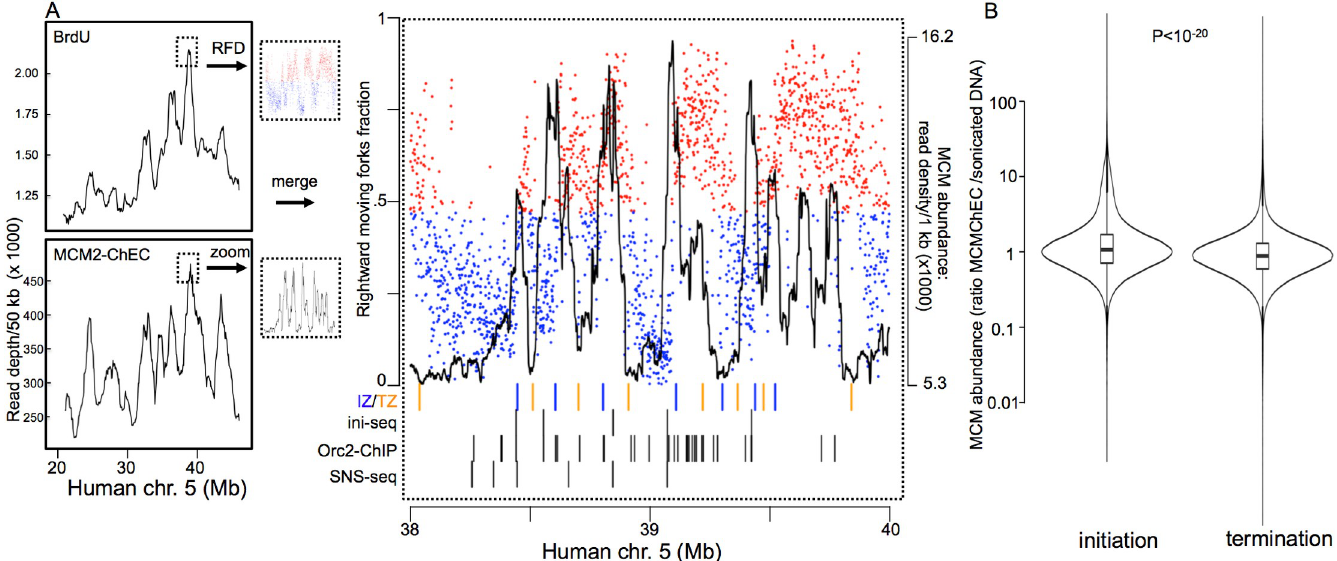
Fig 7. MCM binding in humans with respect to replication initiation and termination zones. (A) Replication, as determined by BrdU incorporation [57] upper left panel) and MCM binding expressed as Mcm2-ChEC read depth of all fragment sizes is shown for HeLa cells. Right panel shows blow-up of indicated area with (red and blue dots are used to emphasize direction of majority of synthesis; data from Petryk et al., 2016 [49]) and MCM binding (black). The centers of initiation and terminations zones (IZ and TZ) are marked by red and yellow tick marks, respectively. Black tick marks show locations of Orc-ChIP [50], initiation site sequencing (ini- seq) [51], and small nascent DNA strand sequencing (SNS-seq) peaks [52]. Data from both MCM2-ChEC replicas were included in this analysis; the two replicas are analyzed separately in S15 Fig. (B) Analysis of replication initiation and termination zones on chr18 show higher MCM binding at the former than the latter (P < 10 − 20 ). MCM binding was expressed as MCM2-ChEC/sonicated G1 DNA read depth ratio. Mean values of MCMChEC/G1 DNA ratios for initiations and terminations were 2.09 (95% confidence intervals extending from 2.08 to 2.11) and 1.41 (95% confidence intervals extending from 1.407 to 1.413),